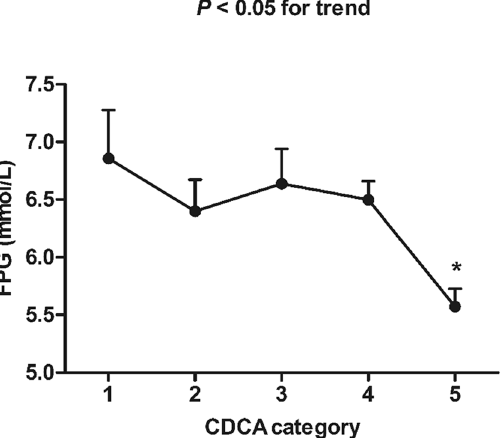
Figure 4. Comparison of FPG between different CDCA categories. CDCA categories are defined as follows: category 1 (fasting CDCA concentration < 1.0 μ g/mL, n = 10), category 2 (fasting CDCA concentration: 1.0– 2.0 μ g/mL, n = 15), category 3 (fasting CDCA concentration: 2.0–3.0 μ g/mL, n = 13), category 4 (fasting CDCA concentration: 3.0–4.0 μ g/mL, n = 16), category 5 (fasting CDCA concentration ≥ 4.0 μ g/mL, n = 11). * P < 0.05, compared with the first CDCA category.